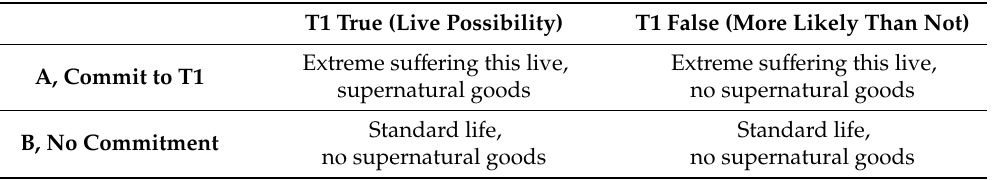
Table 1. Extreme su ff ering and supernatural goods I.